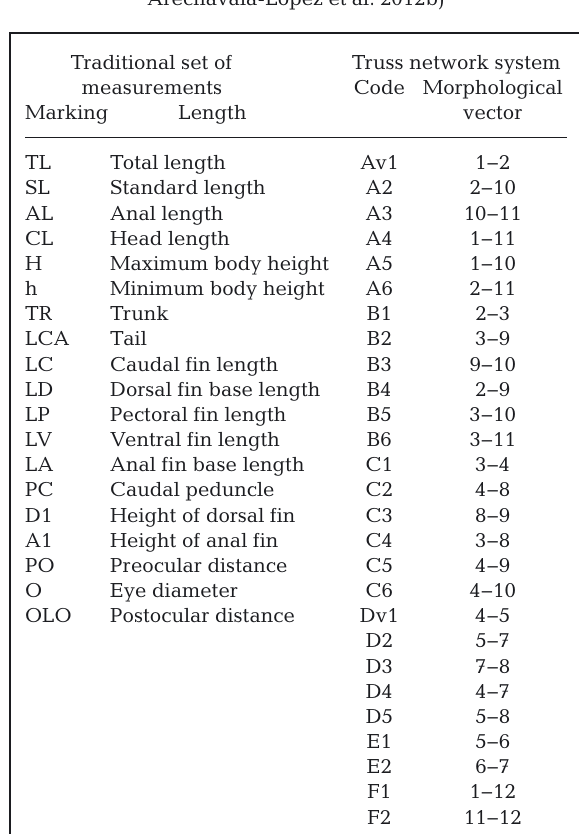
Table 1. Sparus aurata . Traditional set of measurements: 19 morphometric characters were measured (drawn in Fig. 2a), and then expressed as ratios to standard length (SL), total length (TL), or head length (CL) (see Table 2 for ratios). Truss network system: 12 morphometric characters were measured and then used to define vectors (drawn in Fig. 2b):